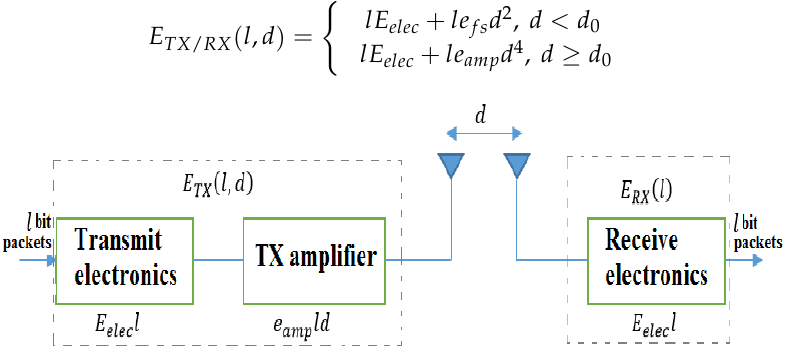
Figure 2. Energy distribution structure.